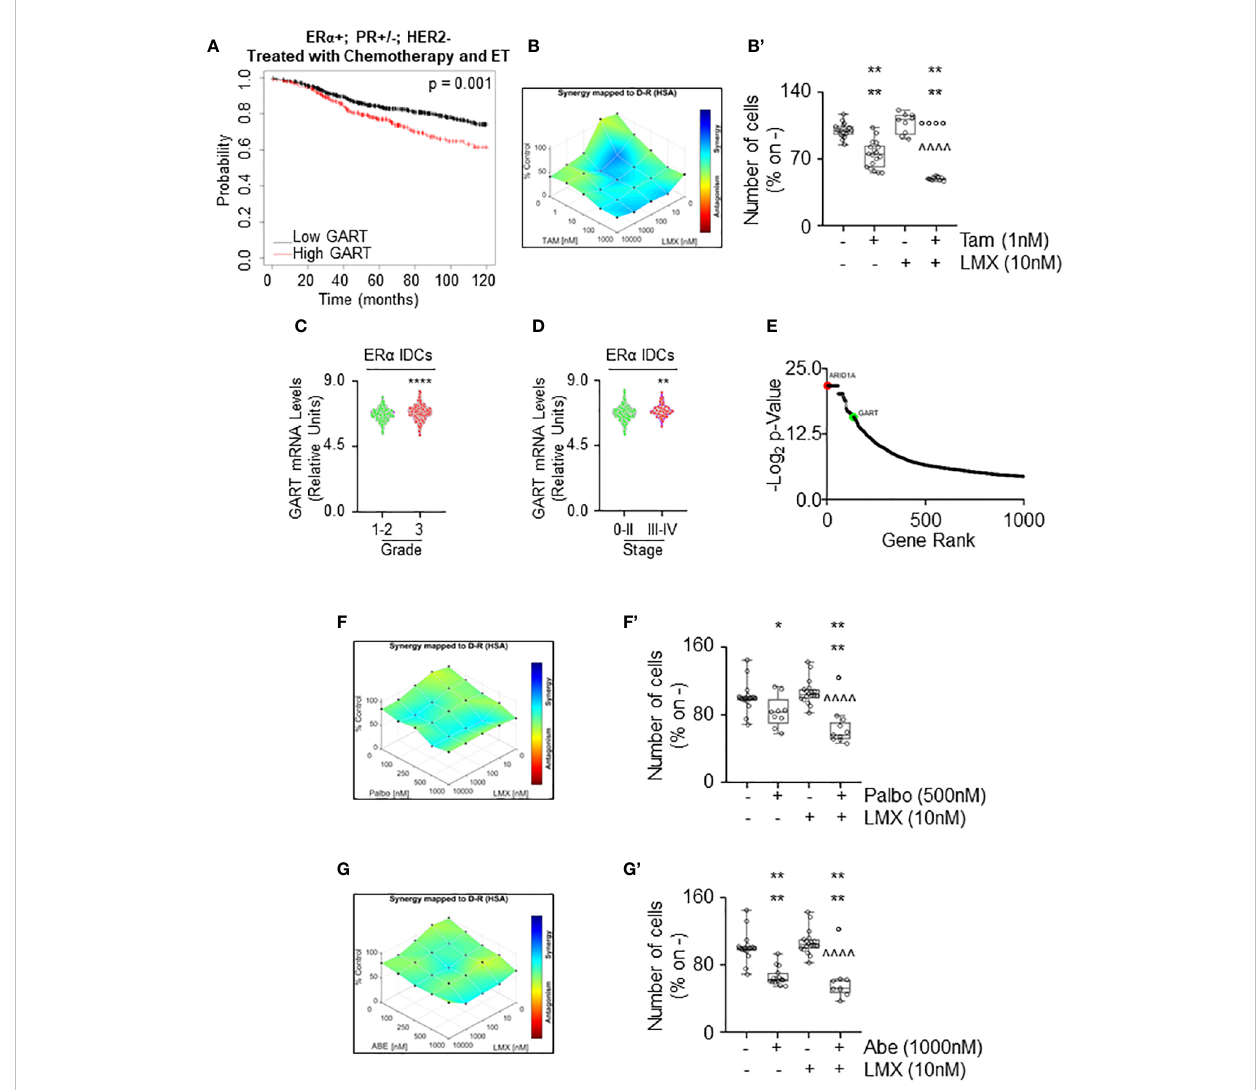
FIGURE 8 The synergy between lometrexol and clinically used drugs in 4OH-tamoxifen sensitive and resistant cell lines. (A) Kaplan-Meier plots showing the relapse-free survival (RFS) probability in women carrying breast tumors expressing ER a , both expressing or not progesterone receptor (PR) but not HER2 treated with chemotherapy and endocrine therapy (ET) as a function of GART mRNA levels. Signi fi cant differences between the RFS are given as p -value in each panel. Data have been downloaded by the website (https://kmplot.com/analysis/). All possible cutoff values between the lower and upper quartiles are automatically computed ( i.e. , auto-select best cutoff on the website), and the best performing threshold is used as a cutoff (35). (B) Synergy map of 12 days-treated MCF-7 cells with different doses of 4OH-Tamoxifen (Tam) and lometrexol (LMX). (B ’ ) Growth curves in MCF-7 cells showing the synergic effect of each combination of compounds with selected doses. Signi fi cant differences have been calculated with the Anova test. **** ( p -value < 0.0001) indicate signi fi cant differences with respect to untreated ( i.e. , -,-) sample. °°°° ( p -value < 0.0001) indicate signi fi cant differences with respect to Tam treated sample. ^^^^ ( p -value < 0.0001) indicate signi fi cant differences with respect to LMX treated sample. GART mRNA levels in ER a -positive invasive ductal carcinomas (IDC) as a function of the grade (C) and the stage (D) of the tumor. **** ( p < 0.0001) and ** ( p < 0.01) indicate signi fi cant differences as calculated by the Student t-test. Data have been downloaded by the cBioPortal (https://www.cbioportal.org/) database. (E) Ranking of the genes in MCF-7 cells, which are important for the development of Tam resistance. Original data extrapolated by the Supplementary Material published in (47) have been used to generate the plot. ARID1A position (i.e., #2 red dot) was indicated as a positive control. GART position (i.e., #133) has been highlighted as a green dot. Synergy map of 7 days-treated Y537S cells with different doses of palbociclib (Palbo) (F) or of abemaciclib (Abe) (G) and lometrexol (LMX). (F ’ , G ’ ) Growth curves in Y537S cells showing the synergic effect of each combination of compounds with selected doses. Signi fi cant differences have been calculated with the Anova test. **** ( p -value < 0.0001) and * ( p -value < 0.05) indicate signi fi cant differences with respect to untreated ( i.e. , -,-) sample. ° ( p -value < 0.05) indicates signi fi cant differences with respect to Palbo or Abe treated sample. ^^^^ ( p -value < 0.0001) indicate signi fi cant differences with respect to LMX treated